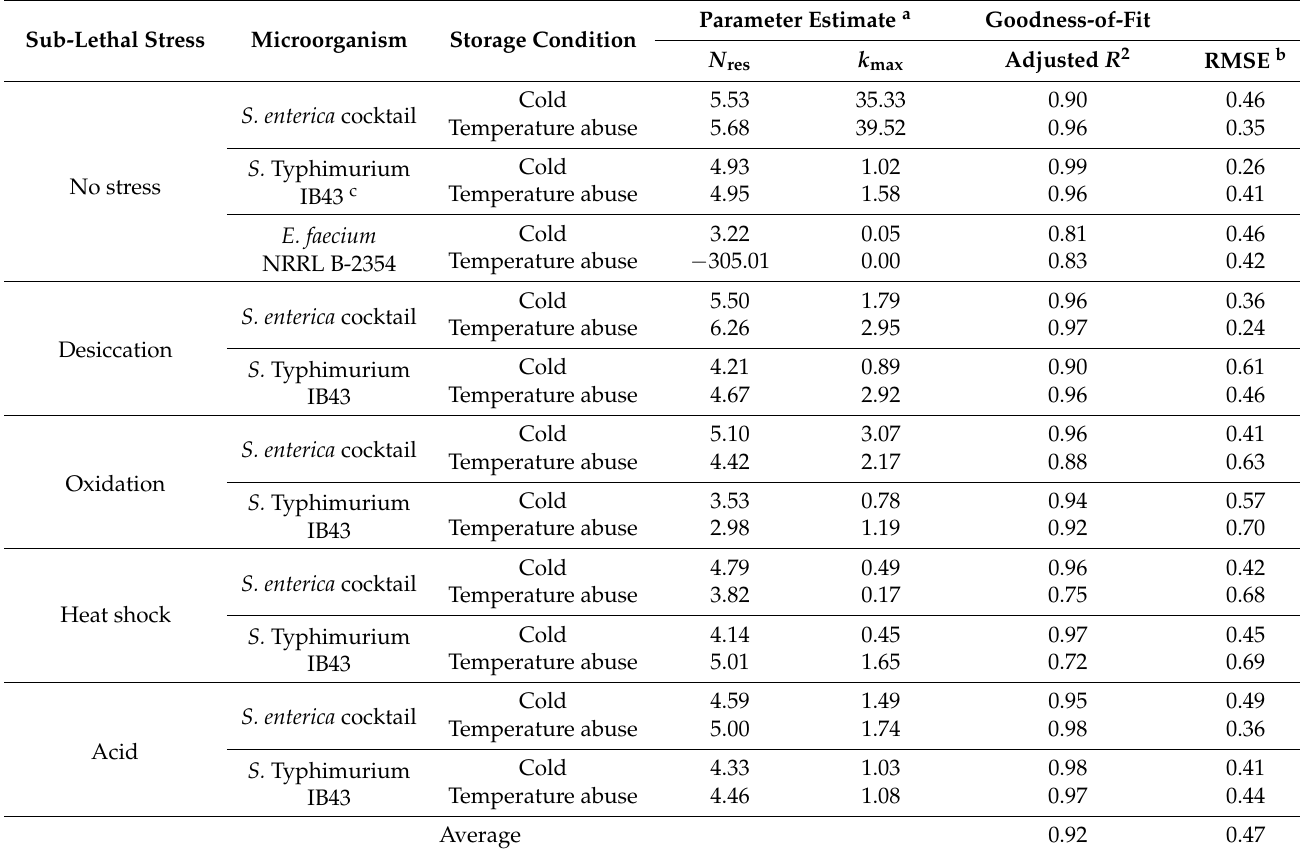
Table 4. Parameter estimates and goodness-of-fit of the Geeraerd model for the persistence of S. enterica and E. faecium NRRL B-2354 on baby spinach under cold and temperature abuse conditions with or without prior exposure to sub-lethal